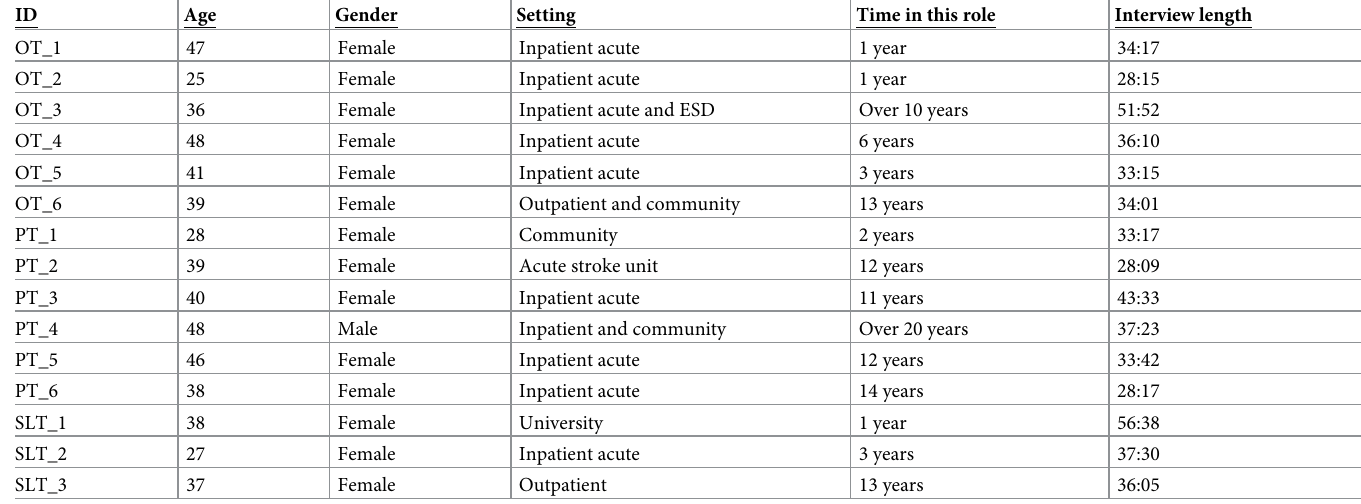
Table 3. Participant demographics: Healthcare professionals (n = 15); Physiotherapists (PTs) (n = 6), Occupational therapists (OTs) (n = 6), Speech and Language therapists (SLTs) (n = 2) and academicians (n =